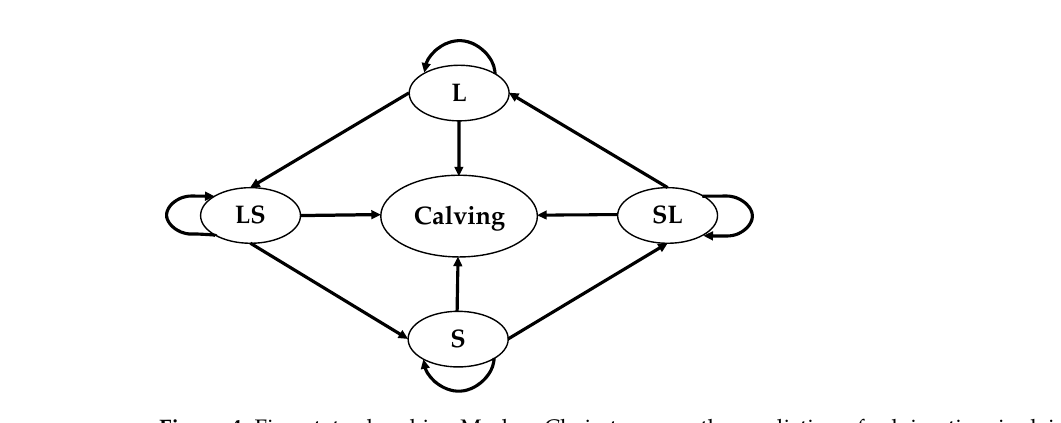
Figure 4. Five-state absorbing Markov Chain to assess the prediction of calving time in dairy cows.